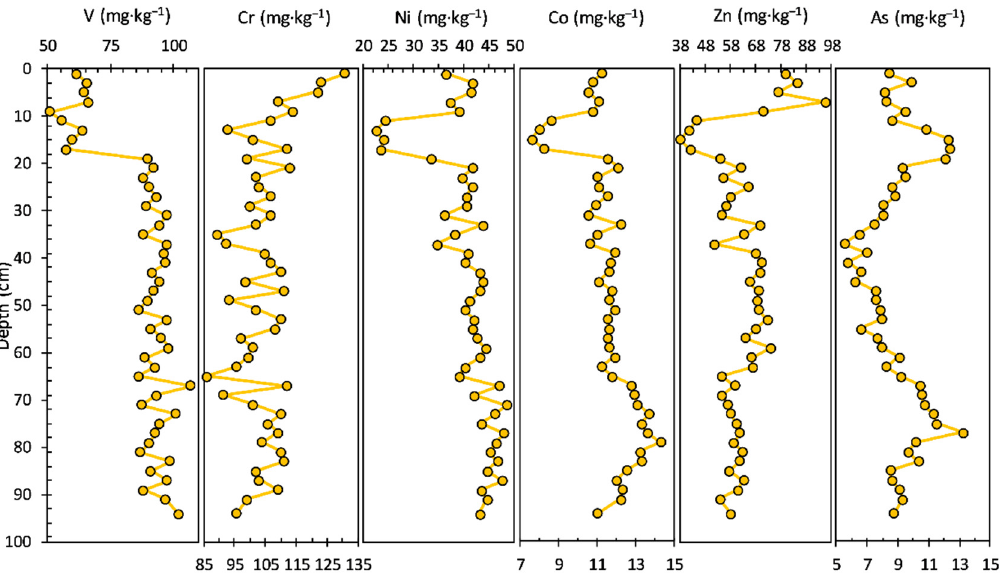
Figure 3. Vertical distribution of geochemical heavy metals (V, Cr, Ni, Co, Zn, As) in the Amara Lake sediment core (94 cm depth).